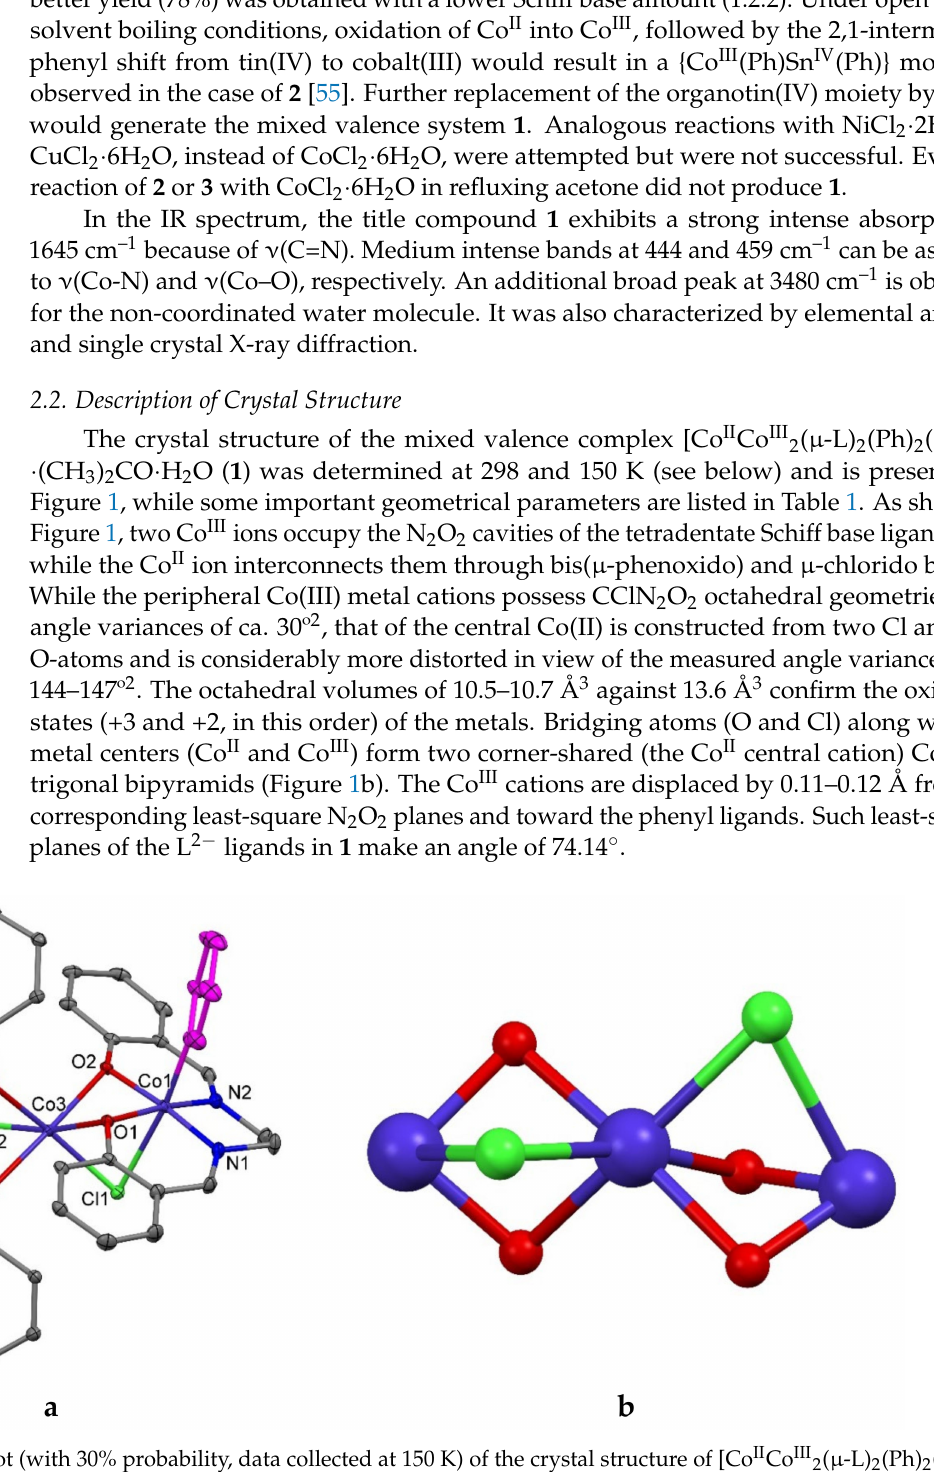
Figure 1. ( a ) Ellipsoid plot (with 30% probability, data collected at 150 K) of the crystal structure of [Co II Co III 2 ( µ -L) 2 (Ph) 2 ( µ - Cl) 2 ] · (CH 3 ) 2 CO · H 2 O ( 1 ) with partial atom labelling scheme. Solvent molecules and H-atoms are omitted for clarity. ( b ) Representation of the Co II -corner shared Co 2 O 2 Cl trigonal